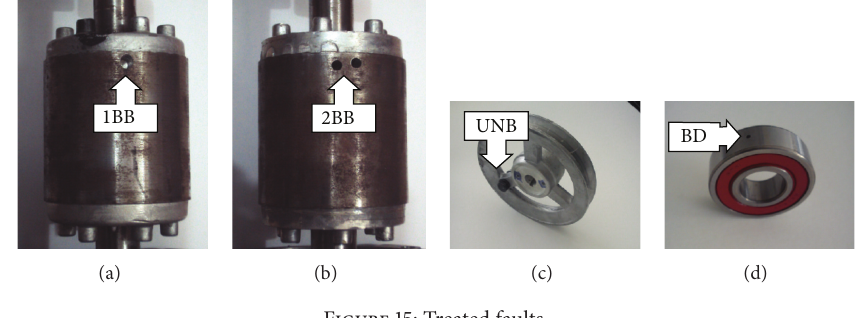
Figure 15: Treated faults.